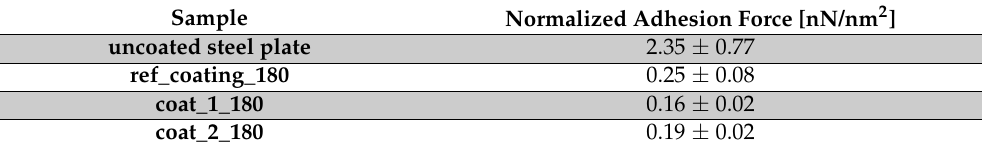
Table 4. Adhesion forces obtained from the AFM pull-off force measurements (normalized to the estimated contact